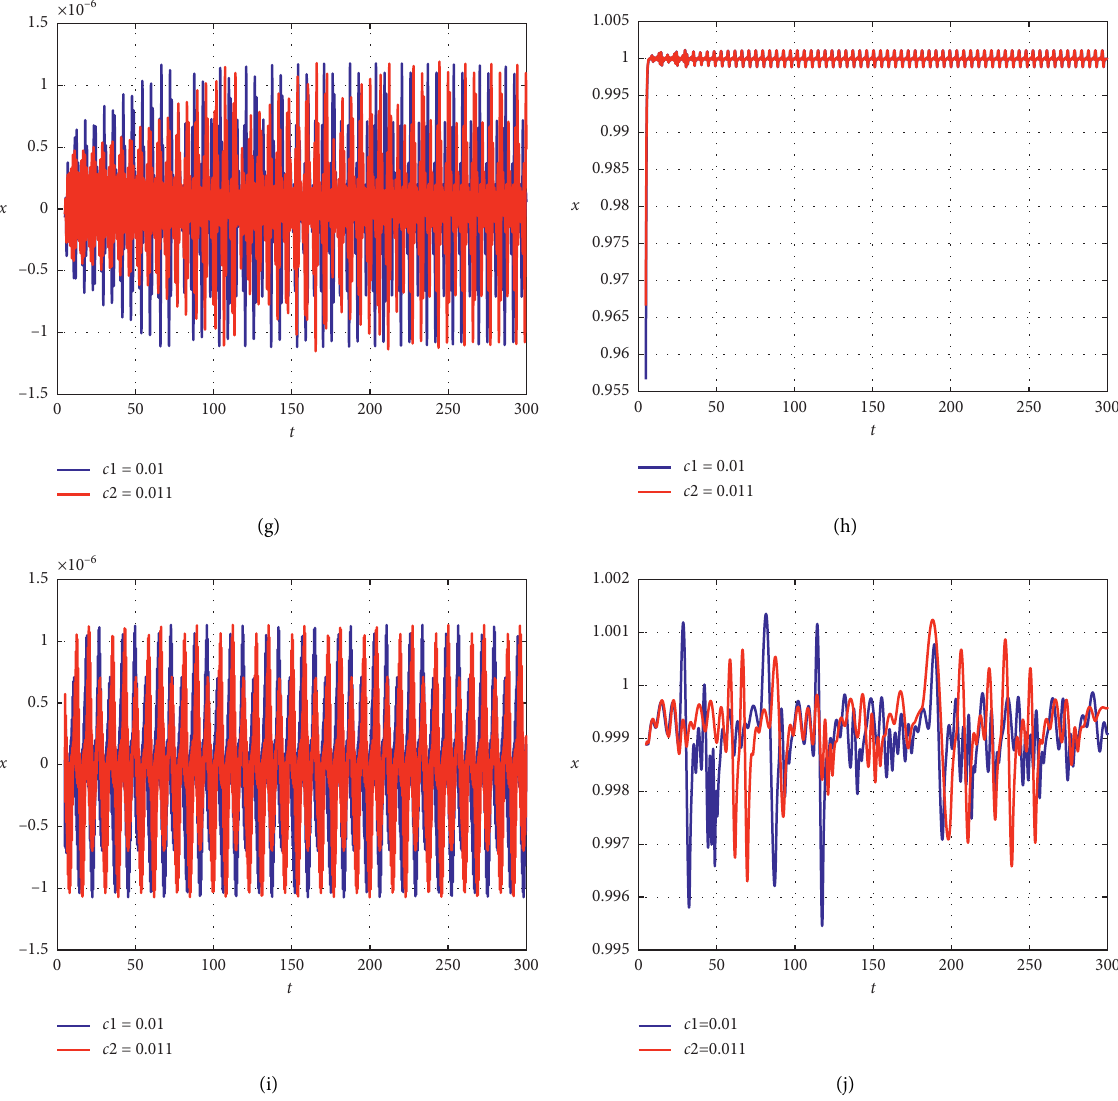
Figure 4: Simulated graph of horizontal enterprises: (a) ① ; (b) ② ; (c) ③ ; (d) ④ ; (e) ⑤ ; (f) ⑥ ; (g) ⑦ ; (h) ⑧ ; (i) ⑨ ; (j) ⑩